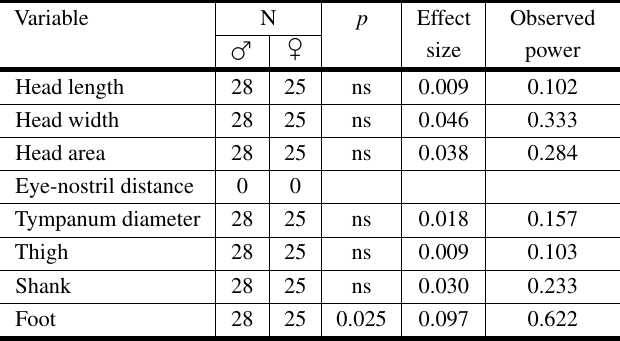
The second sample size problem is at the other end of the spectrum. When available sample sizes are small or not representative of the population as a whole there can be interpretation problems. An ex- ample from our data is the difference in SVL length of male and female L. pentadactylus. The ANOVA results for SVL are significant, with the mean size of females being 13.7 mm larger than the mean size for males. However, there are two other features of the data that militate against this result being considered biologically meaningful. First, the mean measure- ment error is large for L. pentadactylus , 14.9 mm, just exceeding the mean size differences between the sexes. Second, the largest male in the sam- ple is 195.0 mm SVL, whereas the largest female is only 174.2 mm. A plausible explanation to ac-